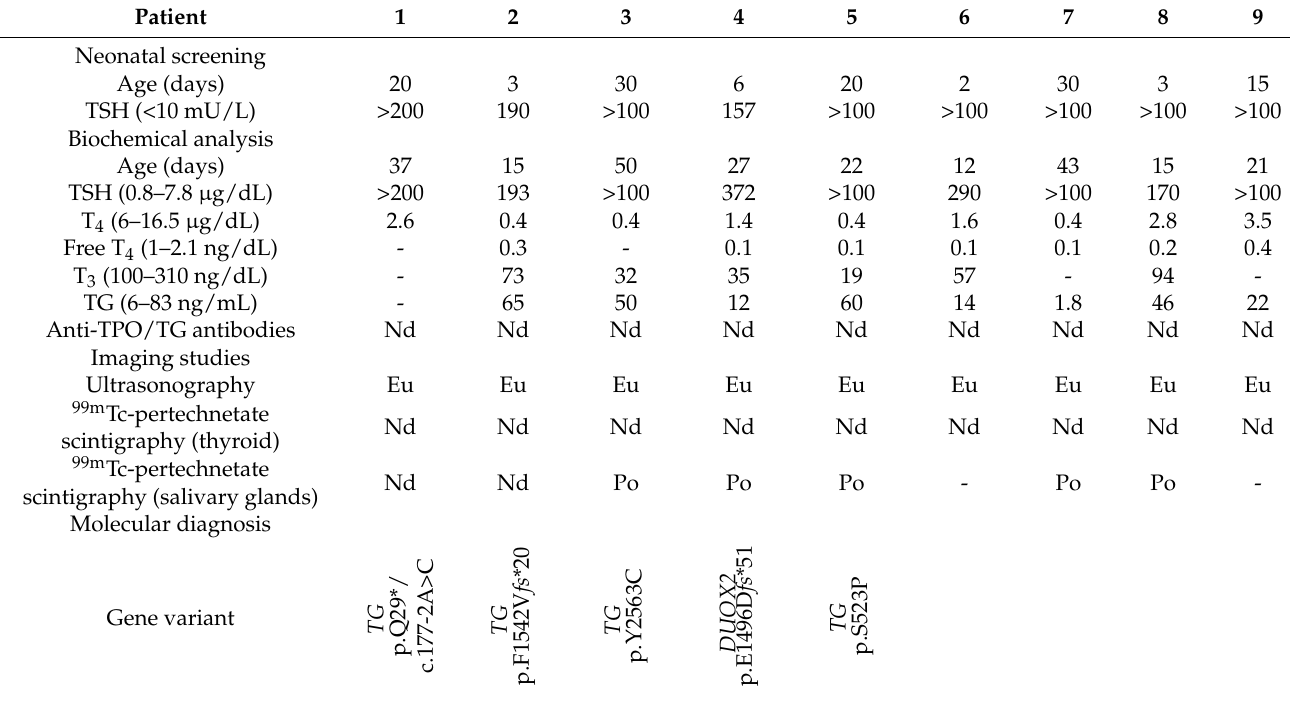
Table 1. Summary of biochemical, imaging, and molecular